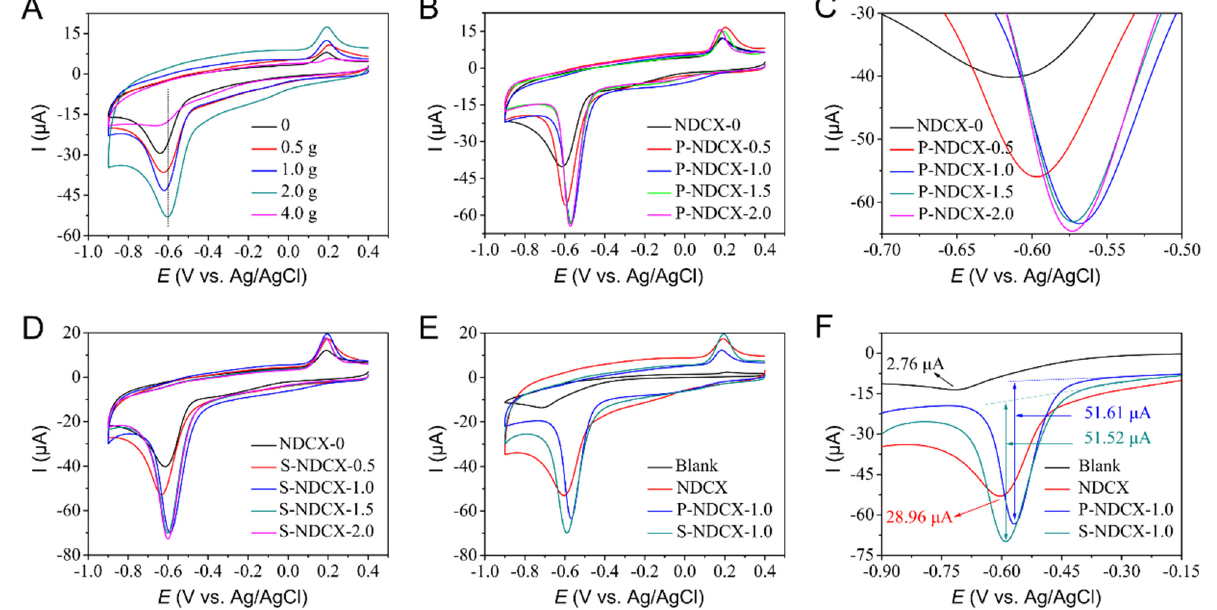
Figure 6. CV curves of ( A ) N ‐ doped carbon xerogels prepared with 0–4.0 g of dicyandiamide, ( B , C ) P ‐ NDCX ‐ m prepared with 0.5–4.0 g of (NH 3 ) 2 HPO 4 , ( D ) S ‐ NDCX ‐ m prepared with 0.5–2.0 g